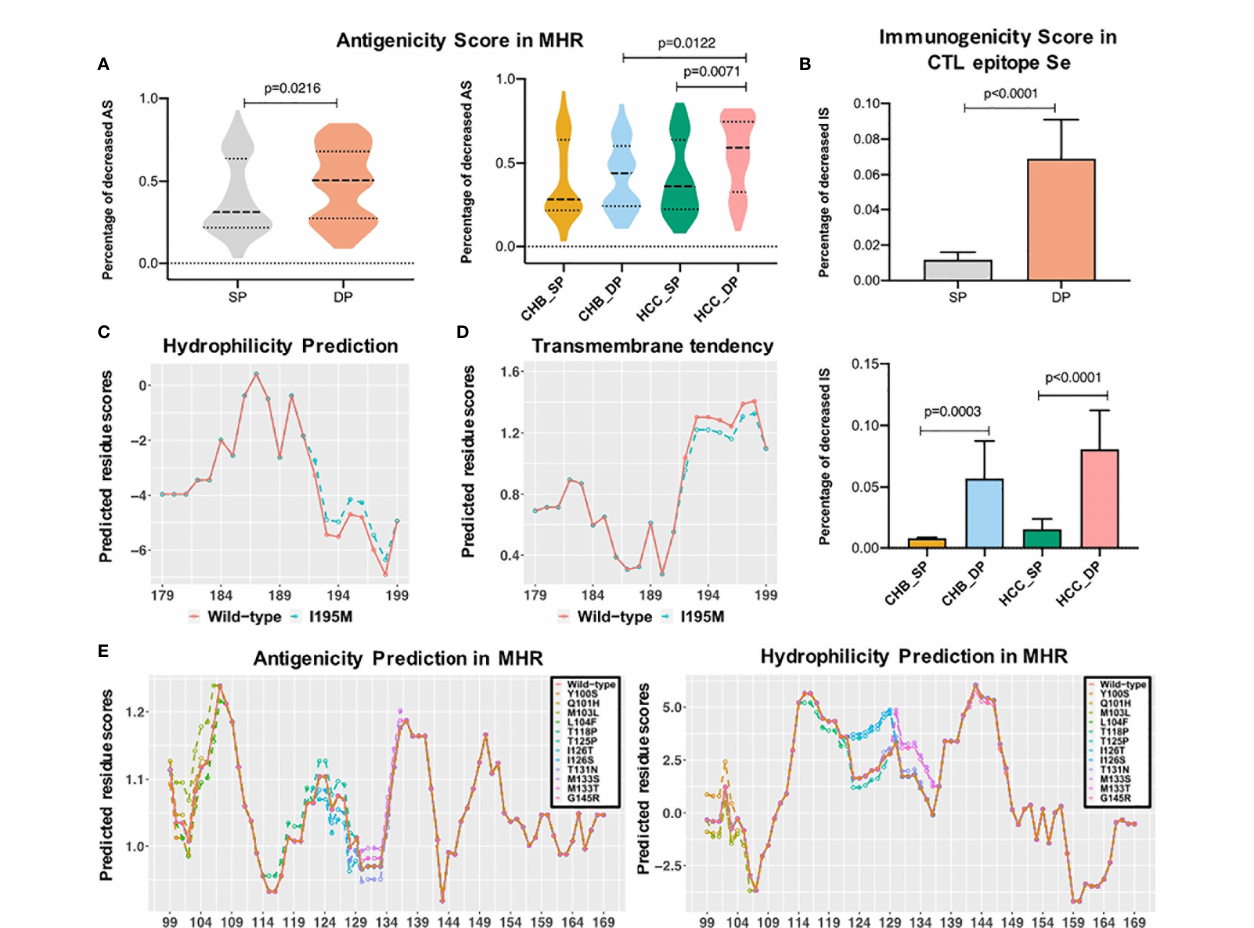
FIGURE 4 | Epitope analysis between double-positive (DP) and single-positive (SP) group in chronic hepatitis B (CHB) and hepatocellular carcinoma (HCC) patients. (A) The violin plot demonstrates that decreased antigenicity score (AS) percentage in the major hydrophilic region (MHR) of DP patients (orange) was higher than that of SP patients (gray), and the bottom plot represents the difference of decreased AS percentage in four subgroups. (B) The left histogram plot demonstrates that decreased immunogenicity score (IS) percentage in the CTL epitope Se region of DP patients (orange) was higher than that of SP patients (gray), and the right plot represents the difference of decreased IS percentage in subgroups among CHB_SP (yellow), CHB_DP (light blue), HCC_SP (green), and HCC_DP (pink) patients. Statistical signi fi cance was evaluated using the unpaired Wilcoxon test. (C) I195M mutation increased the hydrophobicity of the third trans-membrane HBsAg domain for HCC patients. The x-axis represents the position of the third transmembrane region, and the Parker hydrophilicity score (y- axis) was predicted for each residue by using the IEDB website. The orange line refers to wild type, and the green dotted line represents I195M mutation. (D) I195M mutation reduced the transmembrane tendency of the third trans-membrane HBsAg domain for HCC patients. The transmembrane tendency score (y- axis) was determined for each residue by using the ExPASy ProtScale website. (E) Differential mutations identi fi ed between SP and DP groups in fl uenced the antigenicity and hydrophobicity of the MHR. The prediction score (y-axis) was determined for each residue by the IEDB website using the Kolaskar and Tongaonkar antigenicity scale and Parker hydrophilicity method. The orange line refers to wild type, and other colored lines represent different high frequencies of